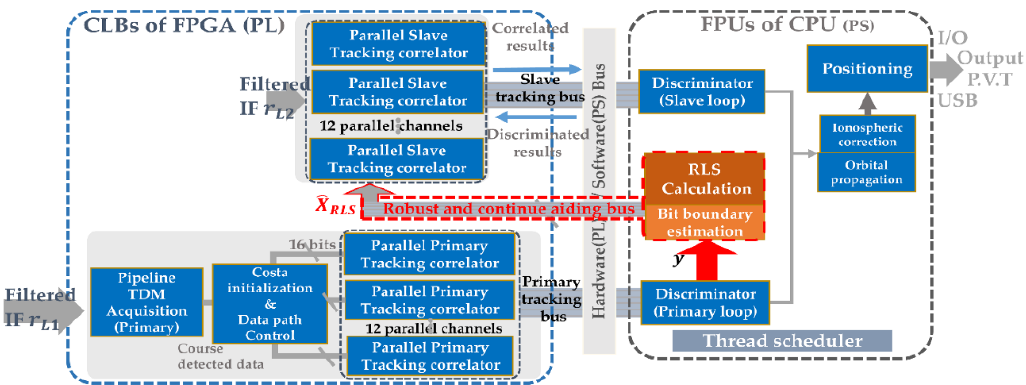
Figure 9. Efficient FPGA implementation with robust inner aid.